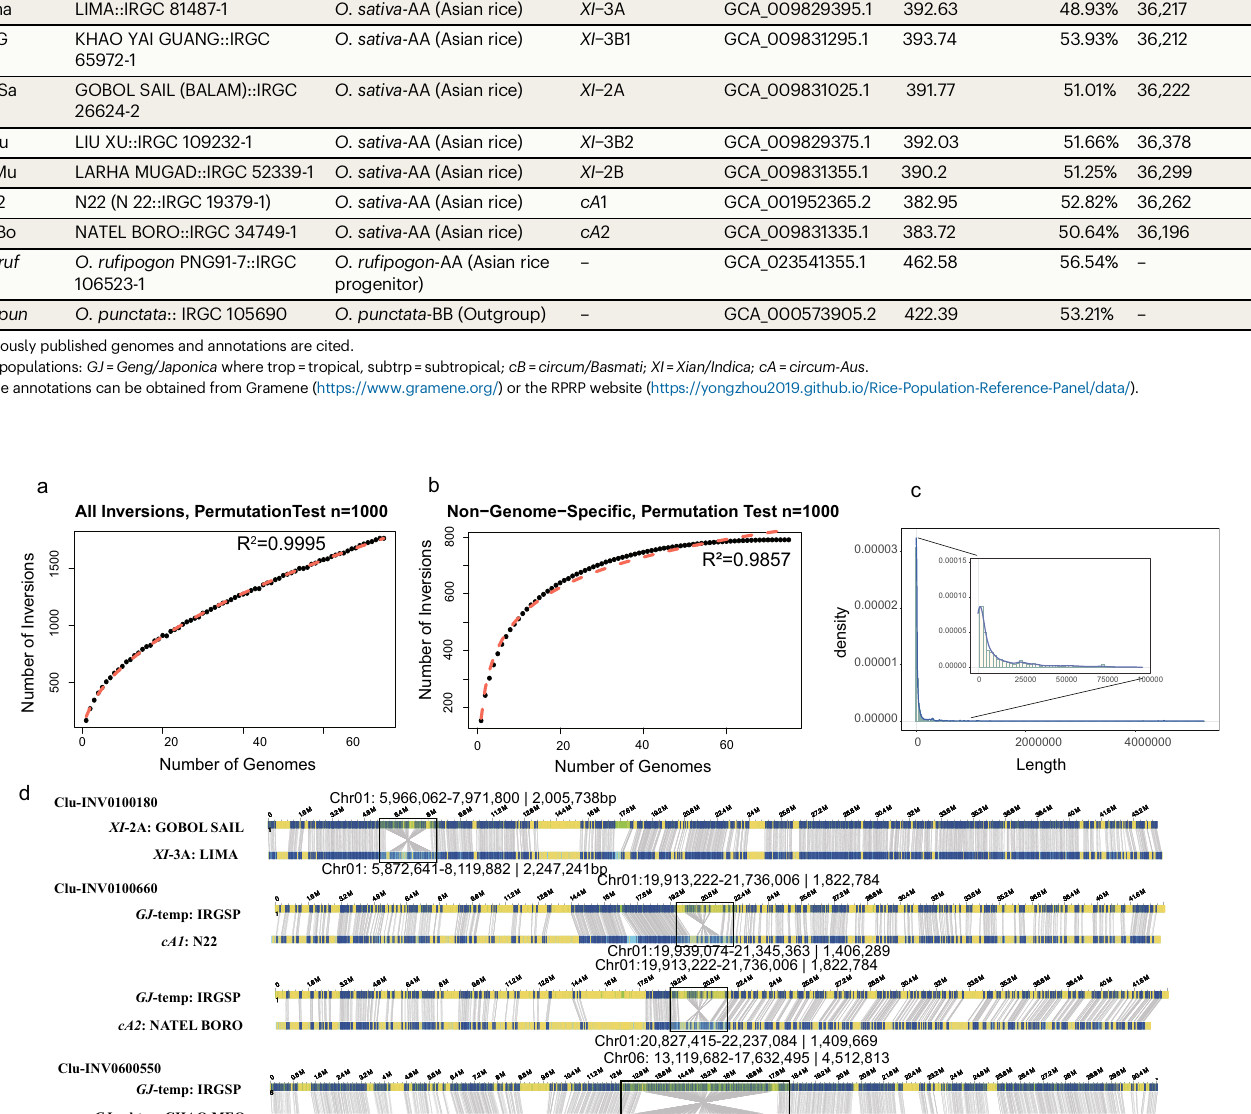
opticalmapusedasareference,thebottomlineshowsthegenomeassemblyofthe varietywiththeinversion.Graylinesconnectrestrictionsitesthatarealigned(blue regions),while yellow segments show unaligned regions. Blackboxes highlightthe position each inversion. Source data are provided as a Source Data fi le.